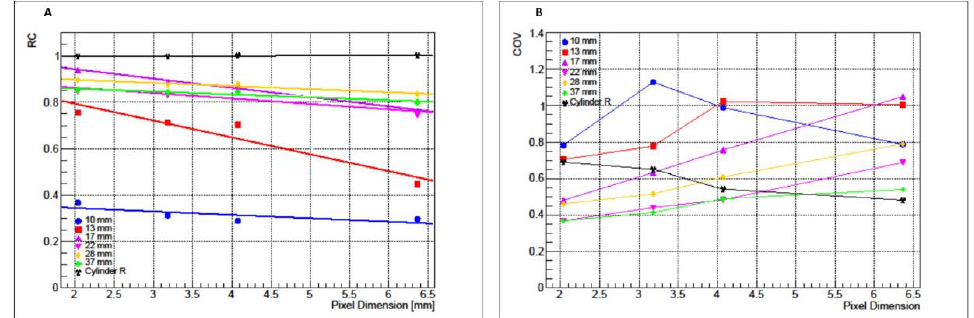
Figure 1. RC ( A ) and CoV ( B ) values for cylindrical phantom (black) and IEC NEMA Body phantom as functions of pixel dimension (inverse of matrix size).